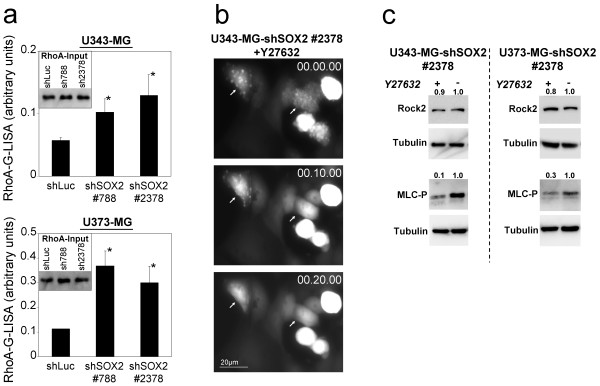
SOX2-RNAi-induced membrane protrusions are associated with increased RhoA activity and are repressed by blocking ROCK. a: RhoA-G-Lisa of U343-MG and U373-MG cells with knockdown of SOX2 compared to shLuc control cells. Protein lysates were prepared and subjected to RhoA-G-LISA. Inlays: RhoA-input in G-LISA. *p < 0.05 when cells with knockdown of SOX2 were compared to the shLuc controls. b: Inhibition of ROCK signaling downstream of RhoA with the small chemical compound Y27632 completely abolish membrane blebbing in U343-MG with knockdown of SOX2. The inhibitor was added at time 00.00.00 (hh:mm:ss). c: Western blot analysis confirms ROCK2 expression in U343-MG and U373-MG cells with knock down of SOX2 which is not affected by treatment with Y27632. The inhibition of ROCK led to diminished levels of phosphorylated myosin light chain (MLC-P). Equal loading of the filters was confirmed by stripping the filters and probing with tubulin antibodies. Densitometric analyses of Western blot signals normalized to tubulin signals are depicted.